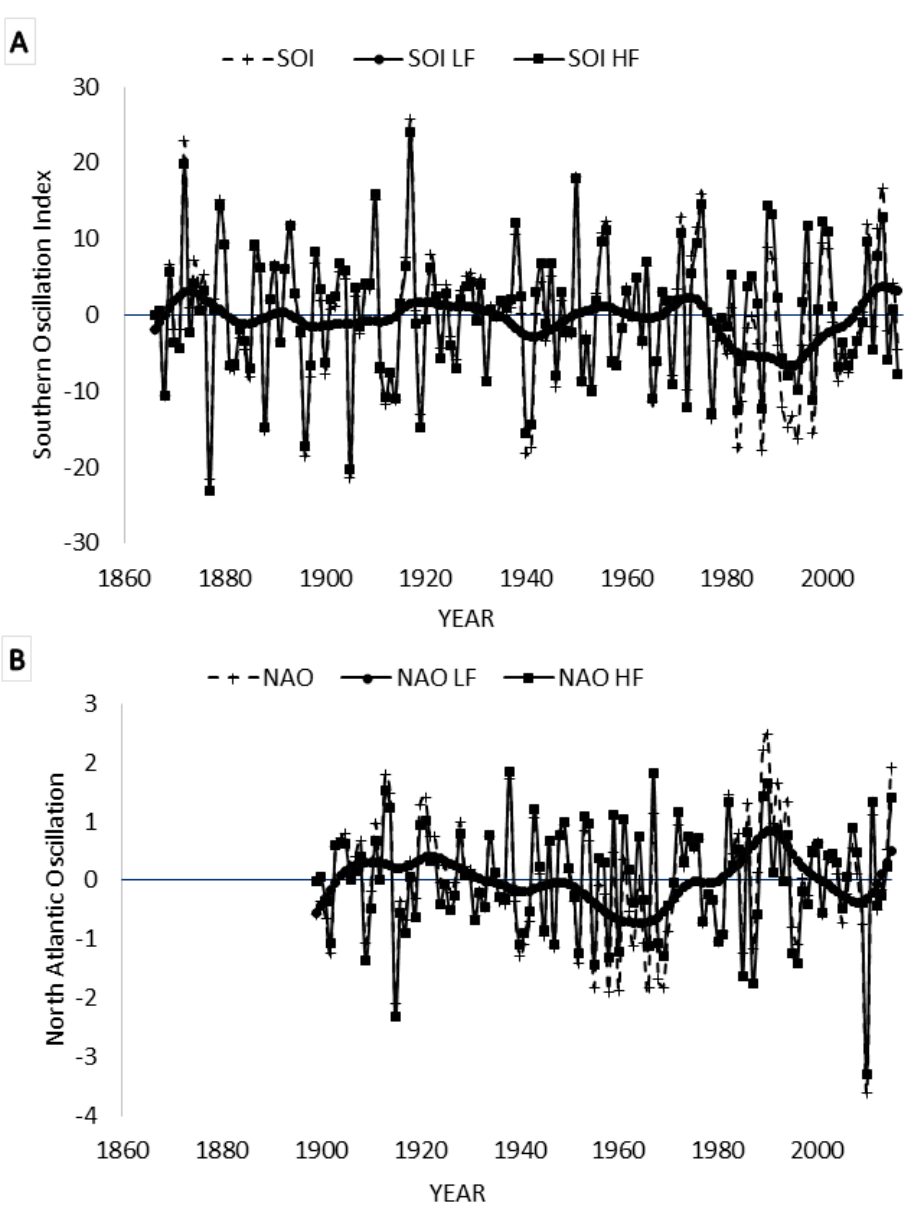
Figure 5. Results of Kalman-filtering. ( A ). Southern Oscillation Index unfiltered data 1866–2014 (SOI, crosses), low frequency component (circles) and high frequency component (squares). ( B ). The same for the North Atlantic Oscillation Index (NAO) 1899–2016.